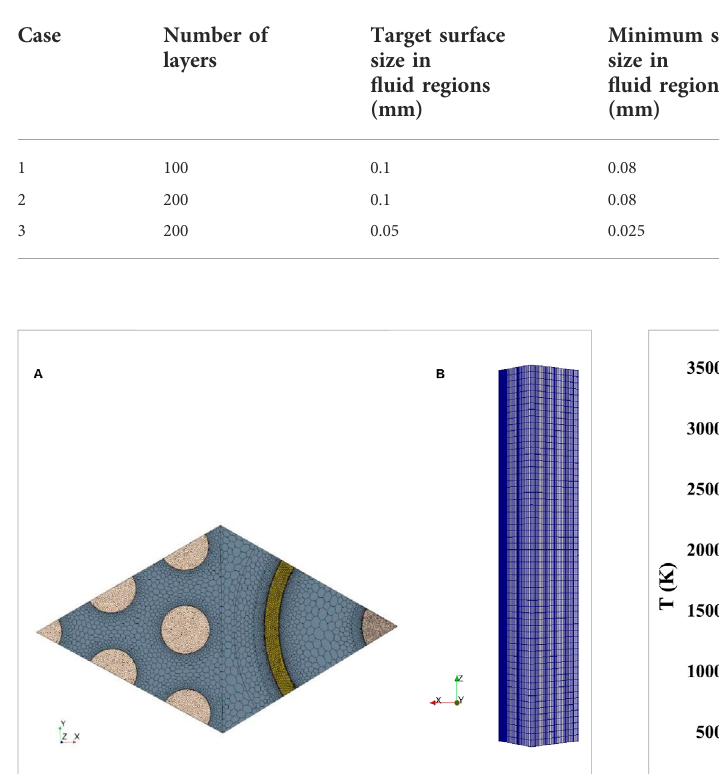
TABLE 2 Mesh independence analysis settings.